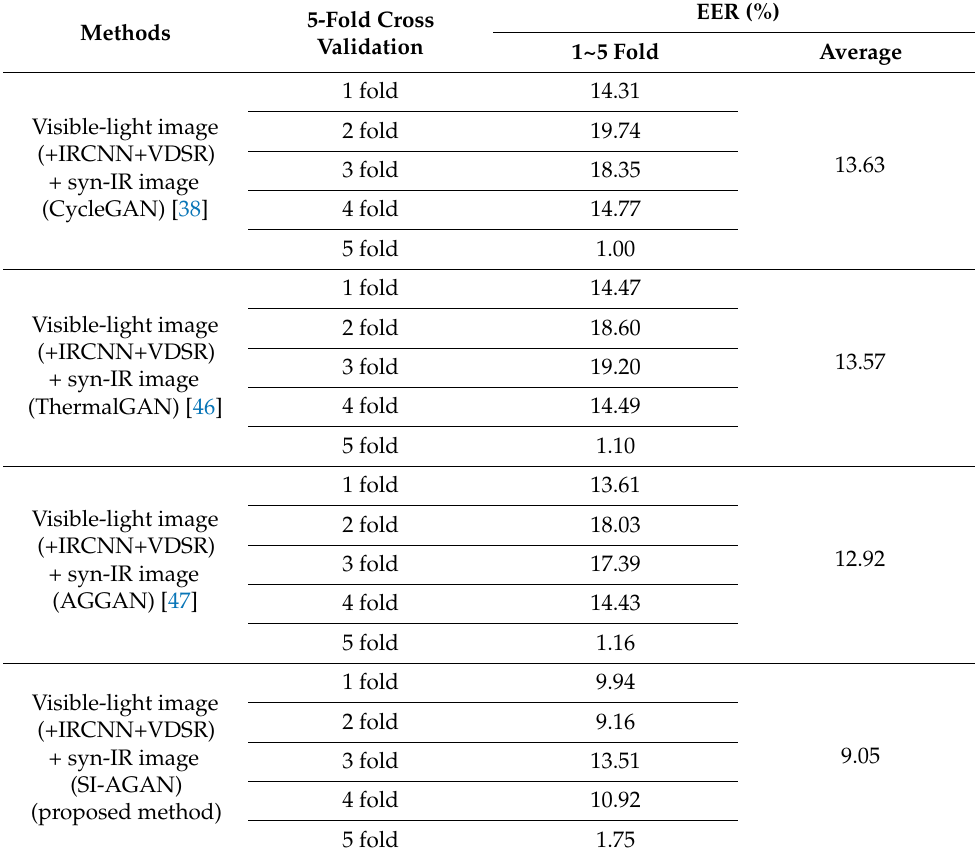
Table 11. Comparison of gender recognition accuracies based on score-level